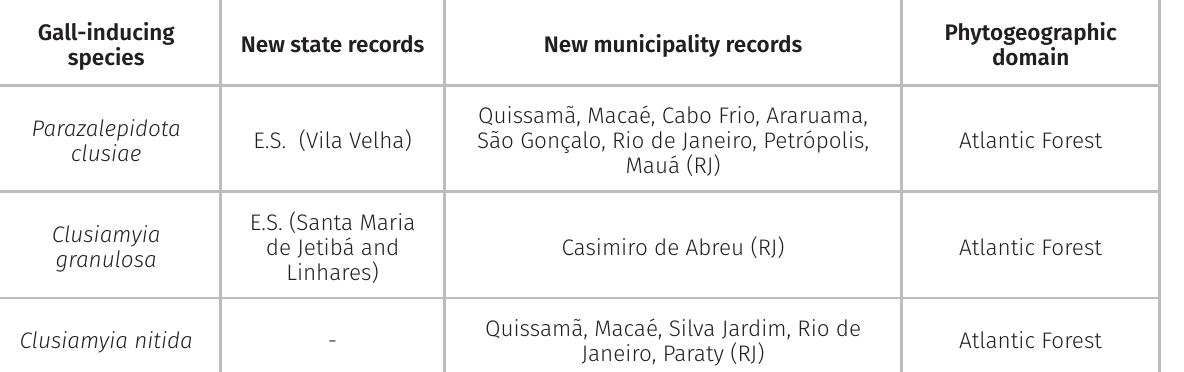
Figure 1. Exsiccates of Clusiaceae with galls induced by Cecidomyiidae (Diptera). a. Gall induced by Parazalepidota clusiae on Clusia fluminense , b. Gall induced by Clusiamyia granulosa on Clusia hilariana , c. Gall induced by Clusiamyia nitida on Clusia lanceolata. Table II. Localities of occurrence of Parazalepidota clusiae , Clusiamyia granulosa , and C. nitida retrieved from herbarium examination.